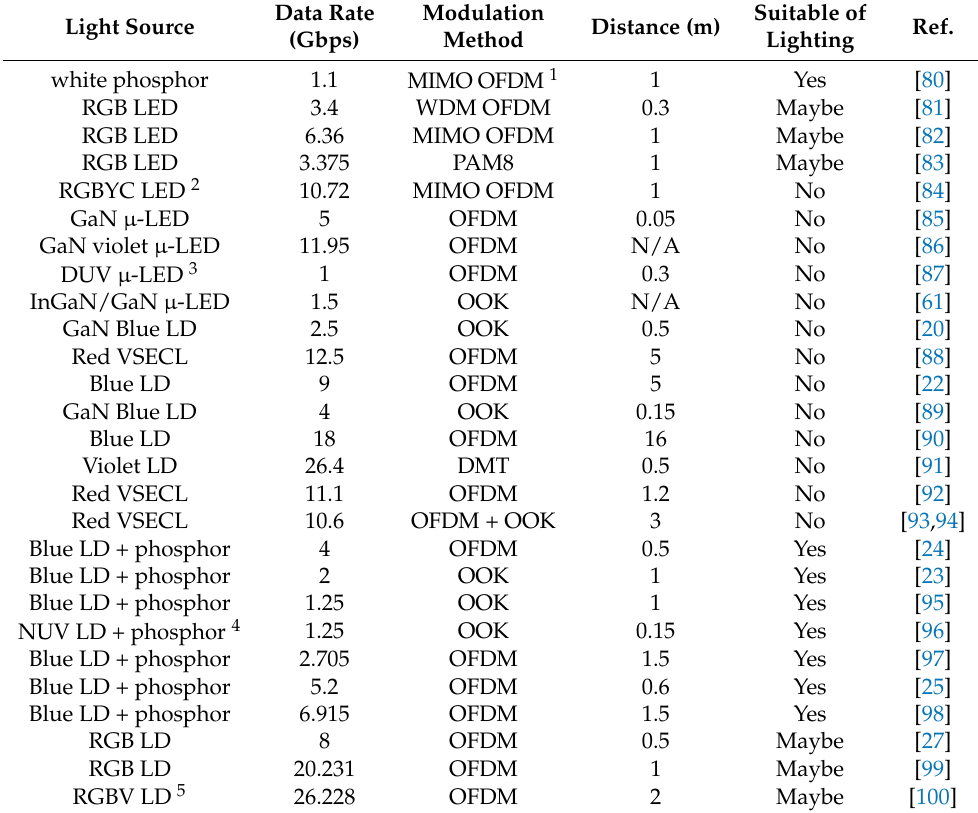
Table 2. Recently proposed high-speed LED and LD-based VLC systems.